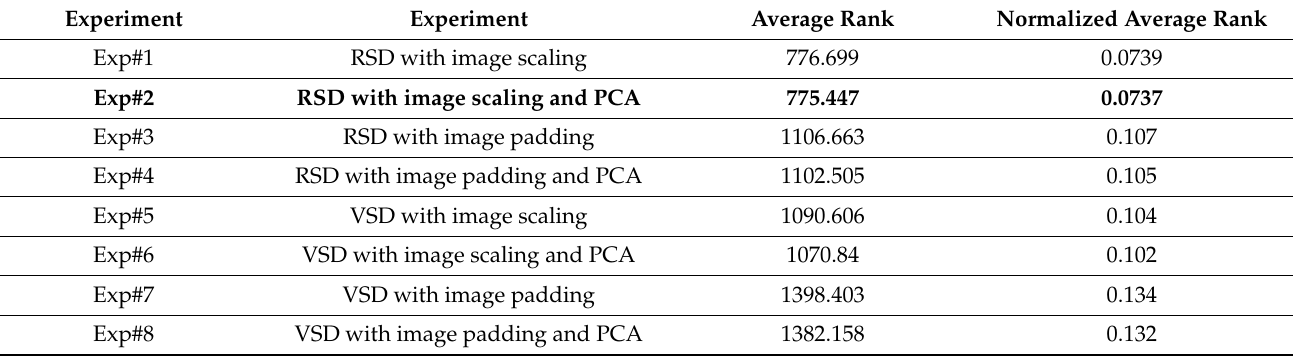
Table 1. Result of the average rank and normalized average rank for each experiment.